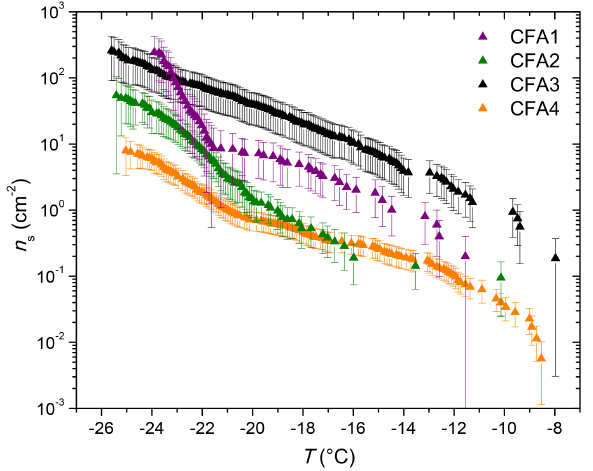
Figure A1. n s ( T ) from LINA measurements. Vertical error bars are the result of propagating uncertainties in weighing, BET surface area, pipette volumes, and distribution of particles in the